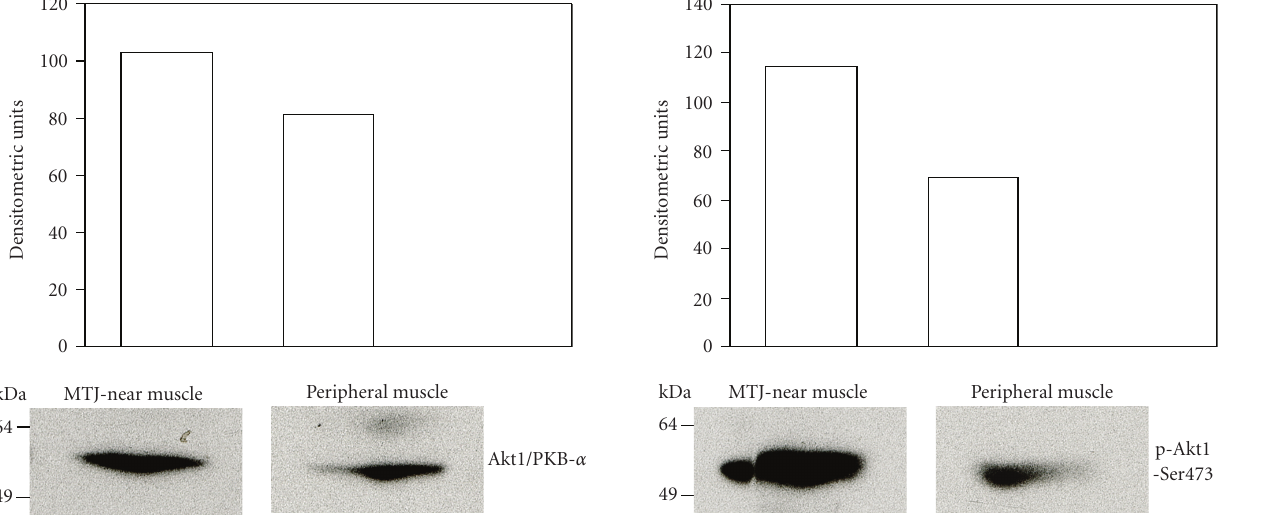
Figure 3: Immunoblot analysis of Akt/PKB in peripheral muscle fibers and in muscle cells near to the myotendinous areas. In peripheral masticatory muscle fibers and masticatory muscle fibers at MTJ, protein extracts were analyzed by immunoblot analysis using an antibody against Akt1/PKB α . The specific immunoblot bands of approximately 60kDa identify Akt1/PKB α in peripheral muscle fibers and in muscle fibers near to the MTJ. The level of Akt1/PKB α in muscle fibers near to the MTJ was higher than that in peripheral muscle fibers.